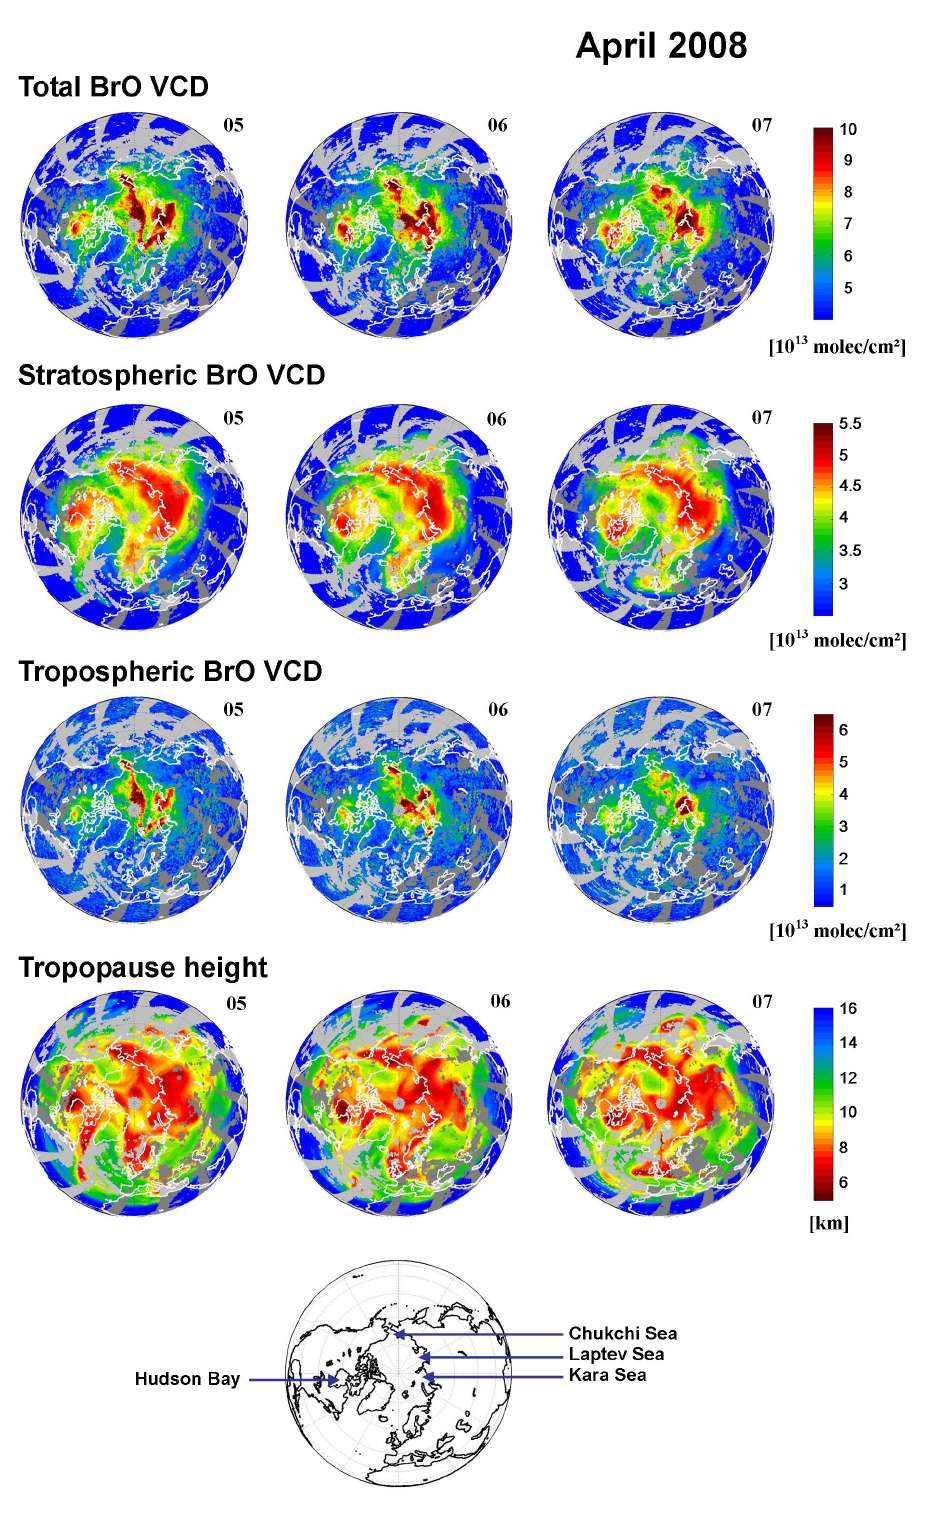
Fig. 10. GOME-2 BrO columns (total, stratospheric and tropospheric) and tropopause height (from ECMWF data). The results are presented for selected days in April 2008 (5 to 7 April, from left to right) in the Northern Hemisphere. The regions contaminated by clouds have been left in